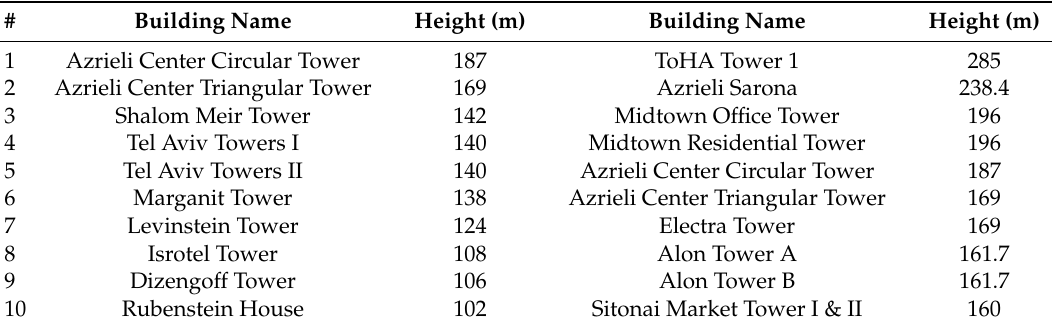
Figure 18. Tel Aviv in 2000 and 2020. Table 28. Tel Aviv’s 10 tallest skyscrapers in 2000 and 2020.